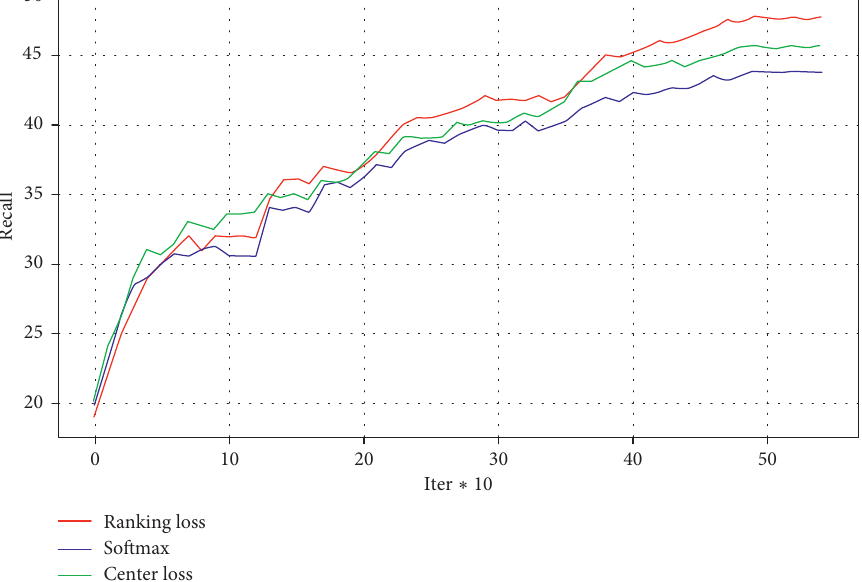
Figure 5: Recall curves when training on Microsoft COCO.